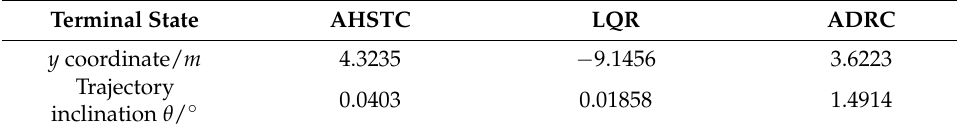
Table 4. Tracking error based on Simulation Analysis